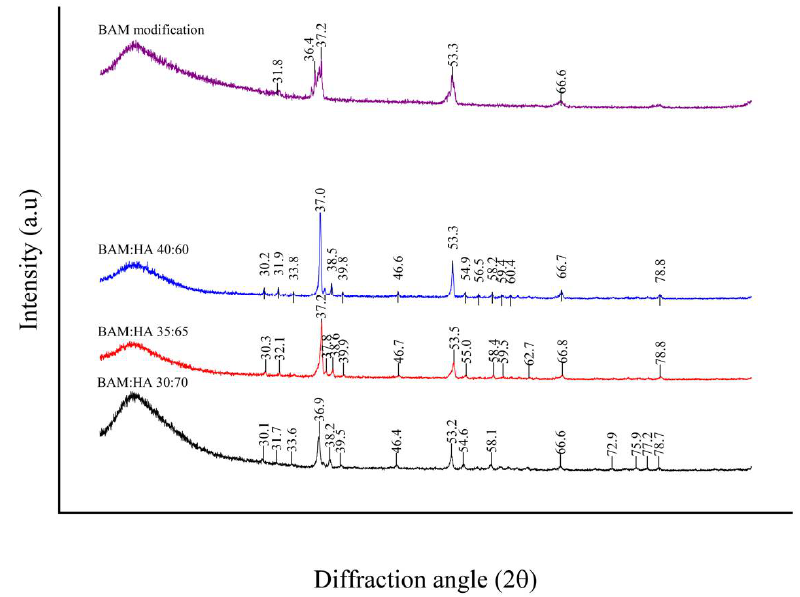
Figure 3. Graph of XRD analysis of all types of bio-composite and modified BAM.